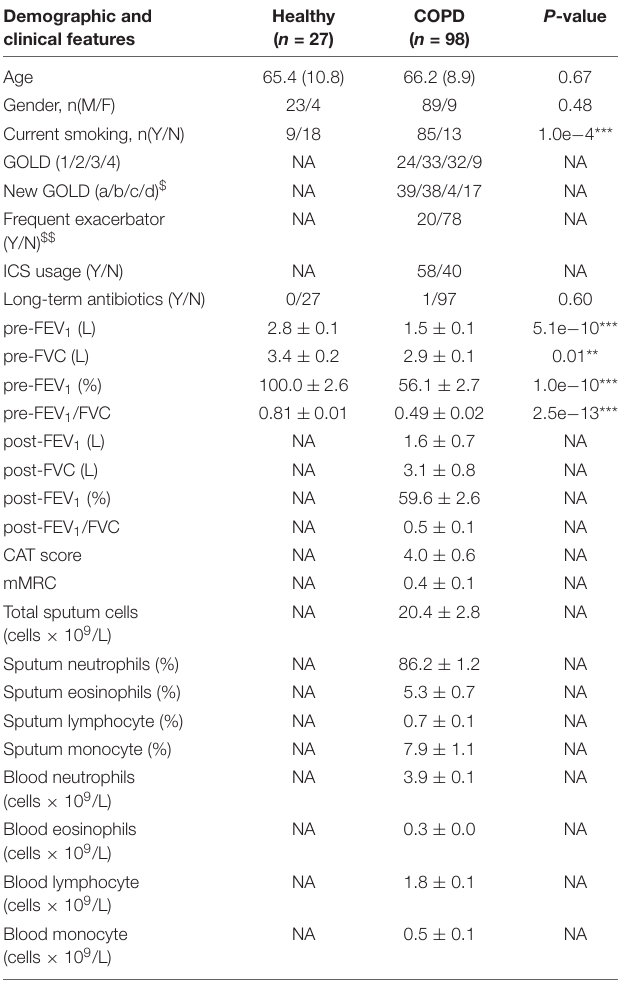
TABLE 1 | Major demographic and clinical characteristics of subjects. Demographic and clinical